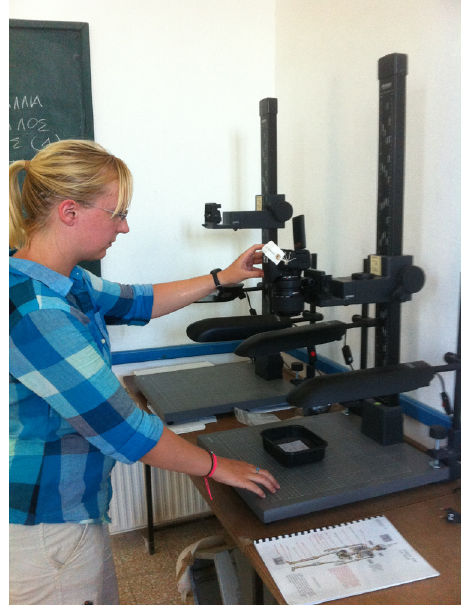
Fig. 3: Jennifer Willoughby at the Bioanthro- pology Field School on Astypalaia, Greece. (Photo R.